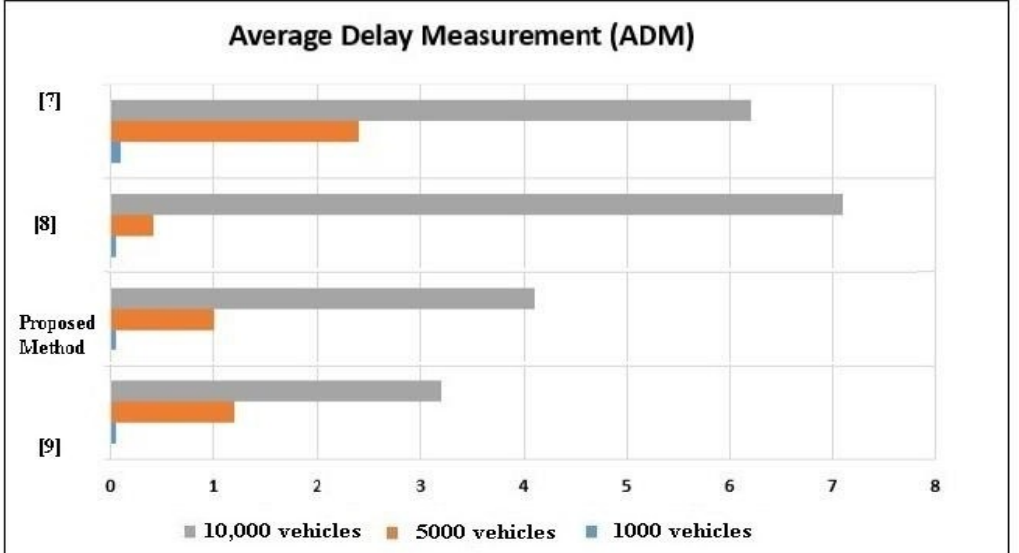
Figure 5. Average delay measurement (ADM).